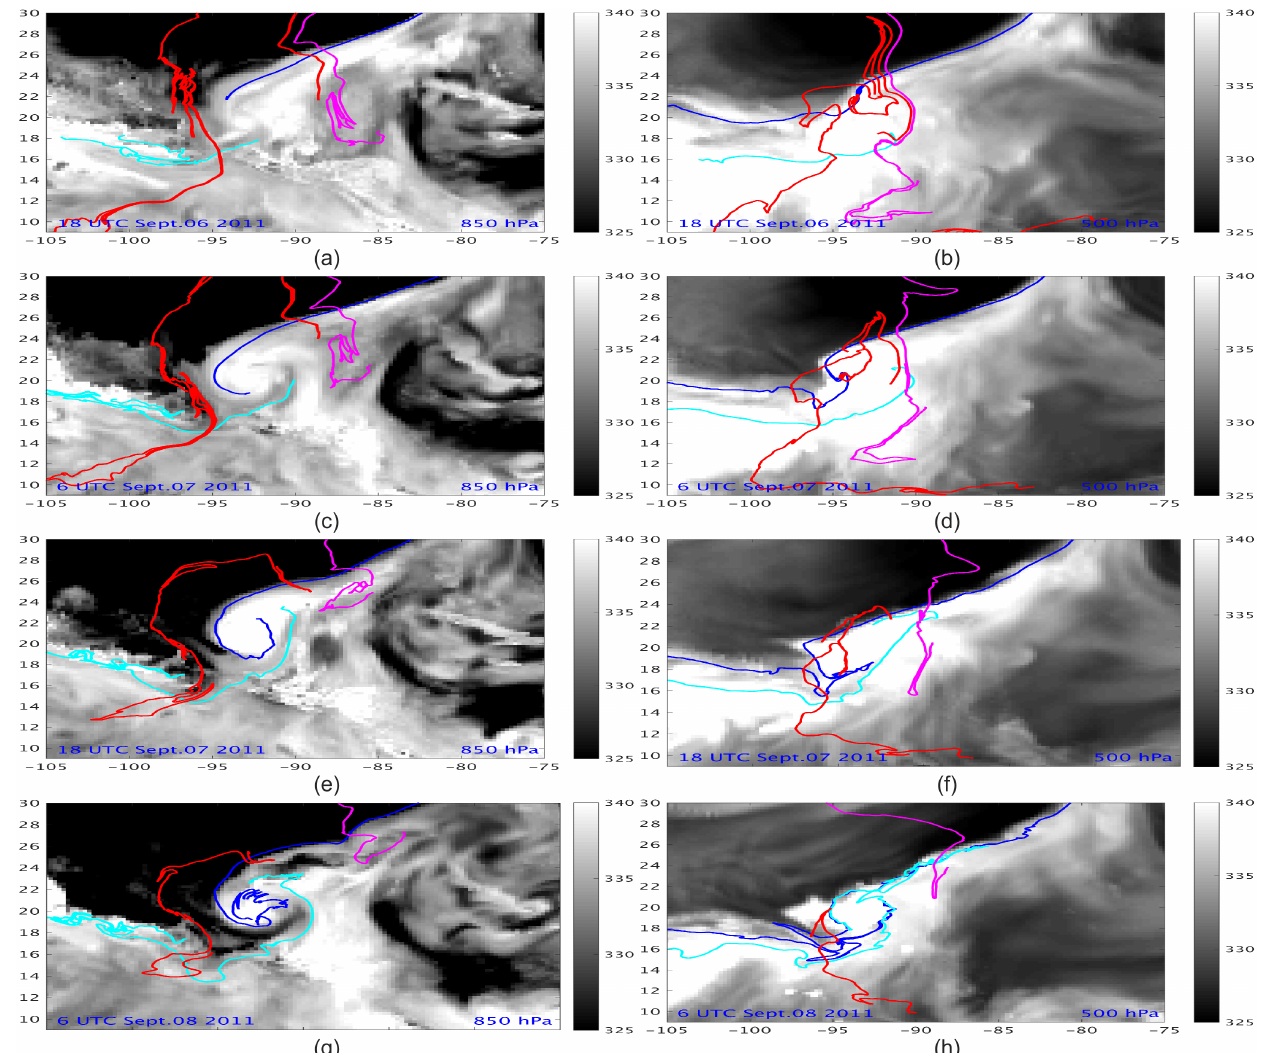
Figure 10. Stable (red, magenta) and unstable (blue, cyan) manifolds are overlaid on the ECMWF θ e field (K) and show the pouch boundary from 18:00UTC on 6 September to 06:00UTC on 8 September at 850hPa (a, c, e, g) and 500 (b, d, f, h)